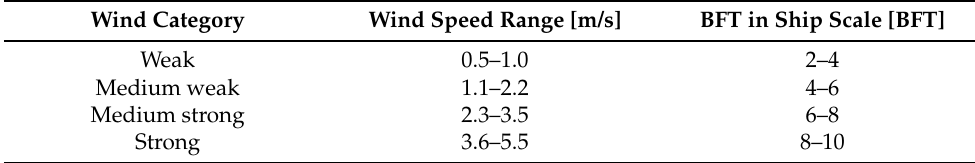
Table 1. Analyzed categories of wind